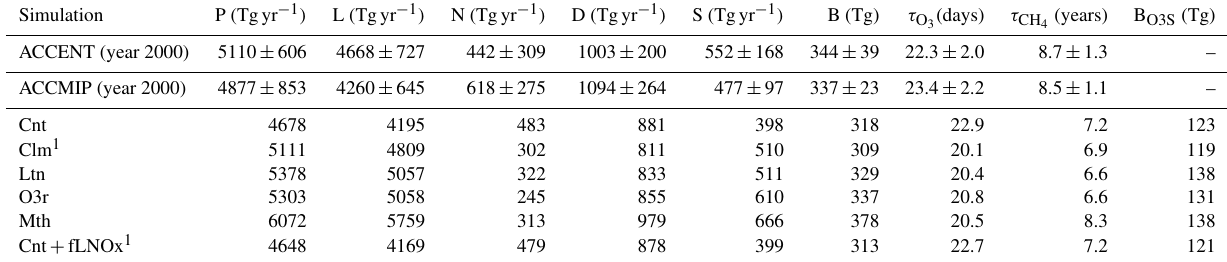
Table 2. Tropospheric ozone budget including the following: ozone production (P) and loss (L) terms based on the gas-phase reaction rates of the O x family (O 3 , O, O 1 D, and NO 2 ) ; net chemical production of ozone defined as the residual of the production and loss terms (N = P − L); dry deposition of ozone (D) term; stratospheric–tropospheric exchange (S; i.e. influx from the stratosphere) term as the residual of the dry deposition and net chemistry production terms (S = D − N); ozone burden (B) term; ozone and methane lifetimes ( τ O respectively) as the ratio between the burden and total losses ( τ = burden / total loss); τ CH for soil uptake (160 years) and stratospheric sink (120 years; Prather et al., 2012); burden for the stratospheric ozone tracer (B O3S ) . Simulation P (Tgyr − 1